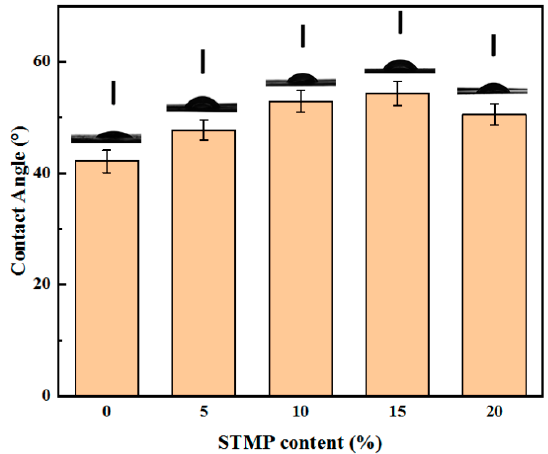
Figure 7. Contact angle results of STMP crosslinked hemicellulose films.